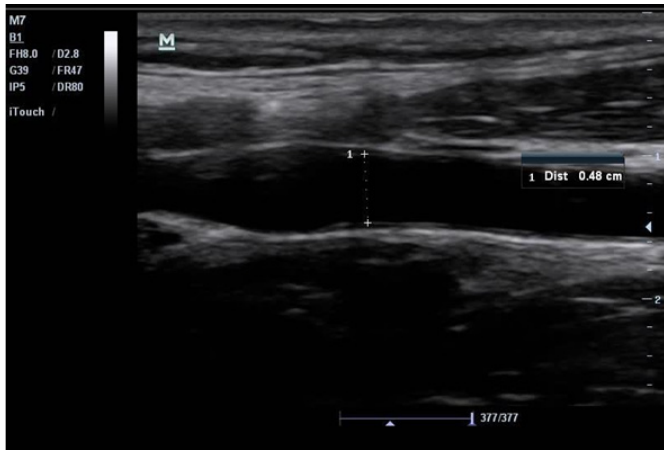
Figure 1. Ultrasound image of common carotid diameter mea- surement obtained within 0.5 cm of the carotid bulb and measured intima to